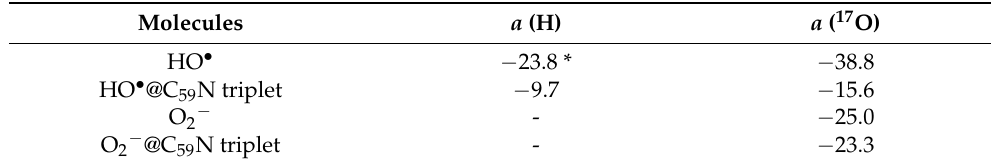
Table 4. Hyperfine coupling constants